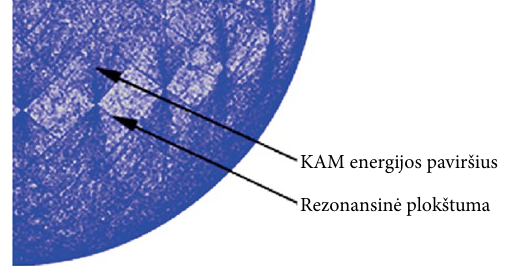
linę struktūrą sudarančių juostų tinklas (14 pav.) yra